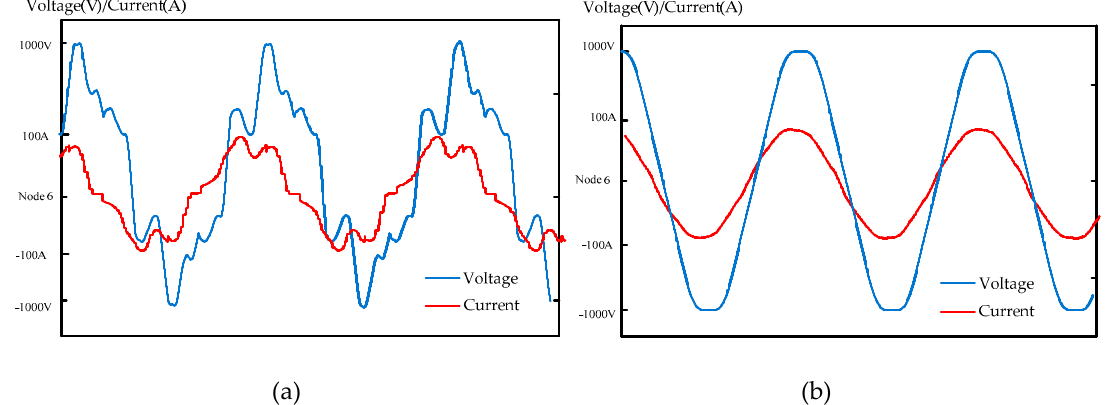
Figure 12. Voltage and current at node six: ( a )VI-APF off, and ( b )VI-APF on .